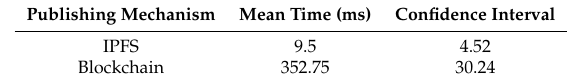
Table 4. Overload time between the IPFS and the blockchain (without CP-ABE